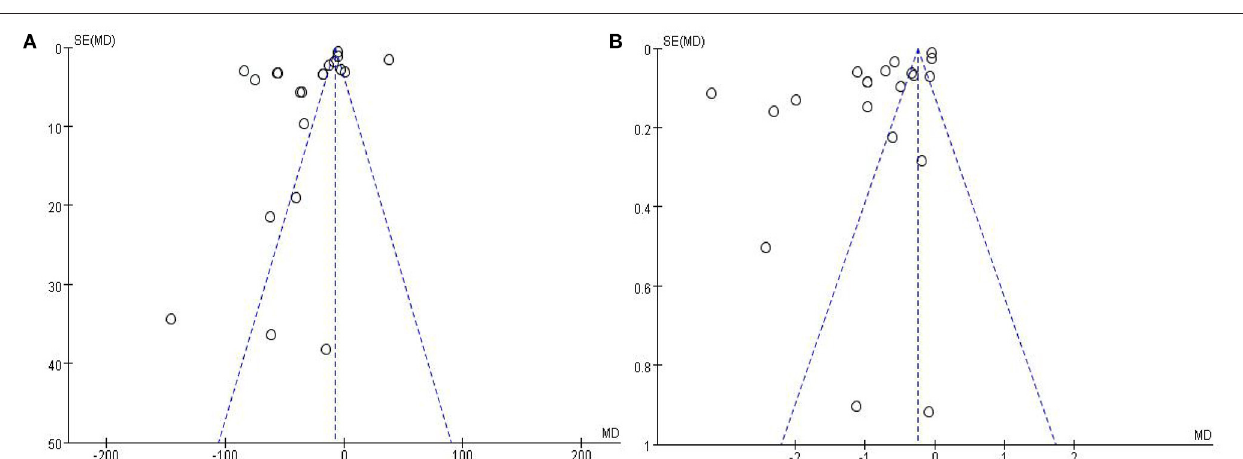
FIGURE 8 | Funnel plots of publication bias for blood urea nitrogen (A) and serum creatinine (B)